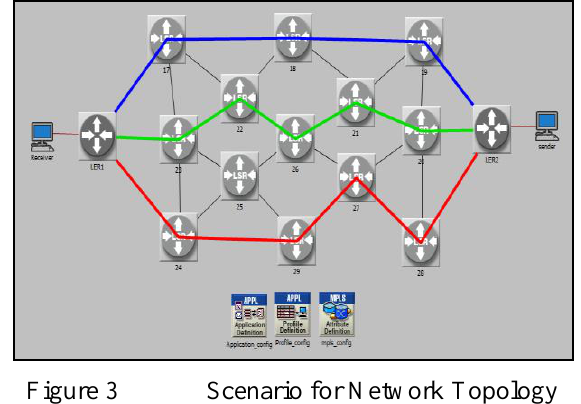
Scenario for Network Topology MPLS over IPv4 and IPv6